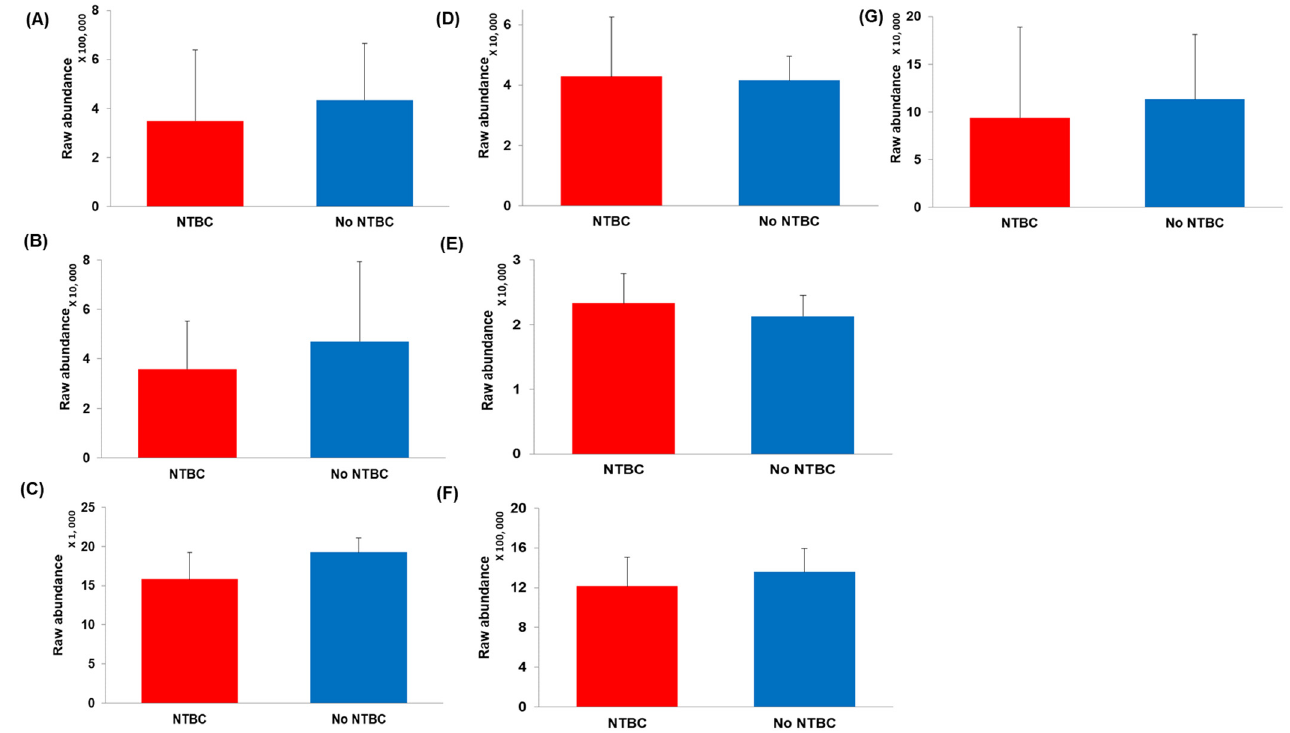
Figure 3. Bar graphs showing mean raw abundances from LC-QTOF-MS analysis for AMRT-matched metabolites that are important in neurotransmitter metabolism. Error bars represent +1 standard deviation of the mean raw metabolite abundance. The abundance of these metabolites between the two experimental groups had a log2 FC < 2.0 and there were no significant differences. ( A ) Tryptophan, ( B ) 5-HIAA, ( C ) Octopamine, ( D ) Adrenaline, ( E ) MHPG, ( F ) Phenylalanine, ( G ) DOPAC. It is impor- tant to note that 5-HIAA and DOPAC showed large variability within each experimental group (i.e., CV > 25%) and were excluded from further statistical analysis. NTBC—nitisinone. All data presented based on positive polarity ( n = 9, No NTBC and n = 8